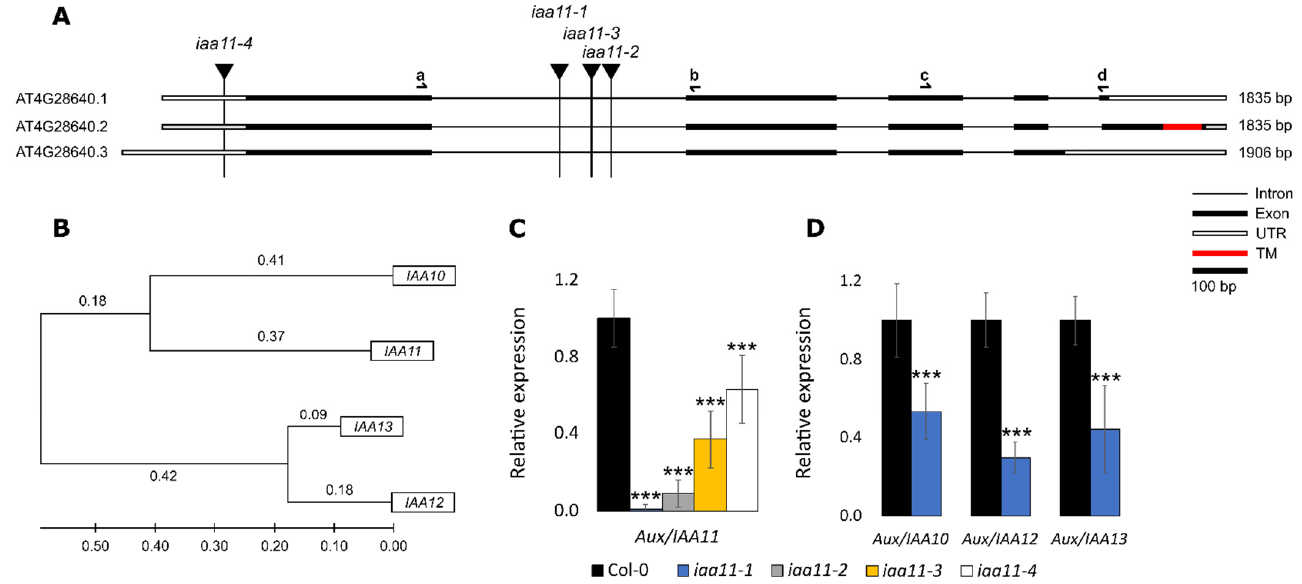
Figure 1. Identification of T-DNA mutants in Aux/IAA11 gene, and phylogenetic analysis of Aux/IAAs. ( A ) Splicing variants of Aux/IAA11 gene. Black vertical lines represent the insertion of T-DNA in iaa11-1 , iaa11-2 , iaa11-3 , and iaa11-4 mutant lines. The red rectangle indicates the localization of the transmembrane (TM) domain in Aux/IAA11.2. Black half arrows illustrate binding sites of the primers used for qPCR. ( B ) Cladogram of protein similarities. Aux/IAA11 clade was prepared using the ClustalW alignment algorithm and the maximum likelihood statistical method in Molecular Evolutionary Genetics Analysis (MEGA) 11 software [60]. ( C ) Relative expression of Aux/IAA11 in tested mutant lines. ( D ) Relative expression of Aux/IAA10 , Aux/IAA12 , and Aux/IAA13 in iaa11-1 mutant background. Relative gene expressions were calculated and normalized with UBIQUITIN-PROTEIN LIGASE 7 (UPL7 ) and YELLOW-LEAF-SPECIFIC GENE 8 ( YLS8 ) as references, using the Relative Expression Software Tool (REST 2009) (n = 6, *** p < 0.001). Error bars represent the standard deviation.